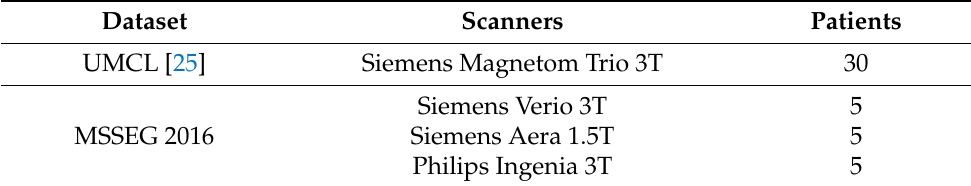
Table 1. Dataset